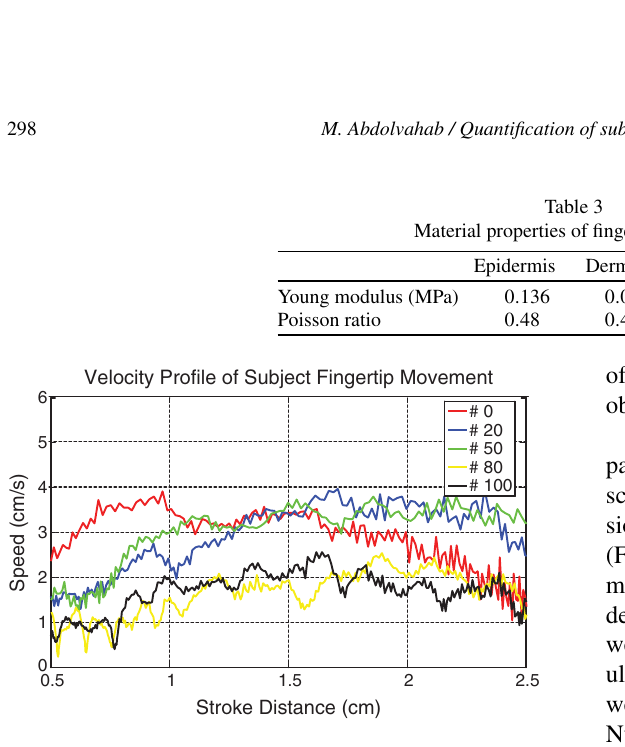
Fig. 5. Velocity variation during the subject’s fingertip movement over the samples for the stickiness evaluation.